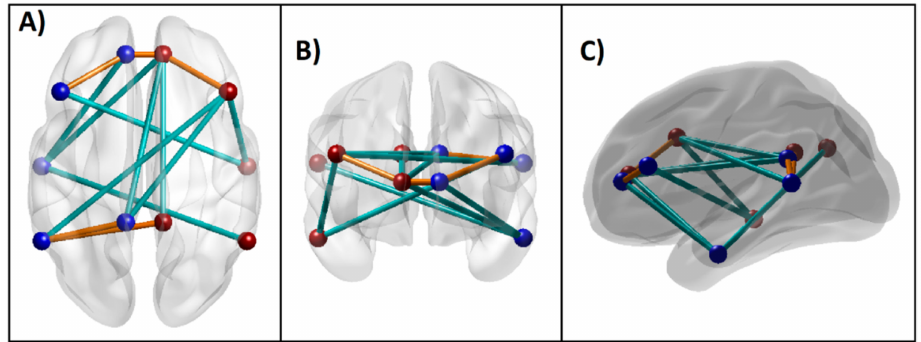
Figure 5. Significant DMN connections that contributed to the Random Forest classification of AUD from CTL individuals based on importance parameters including the p -value ( p < 0.01), as listed in Table 3. These connections (i.e., edges) across the seed regions (i.e., nodes) within an anatomical brain template are shown: ( A ) axial (top) view; ( B ) coronal (front) view; and ( C ) sagittal (left side) view. The blue and red beads represent left and right-sided nodes, respectively, and the edges in orange and cyan lines represent hyper- and hypo-connectivity, respectively, in the AUD compared to the CTL